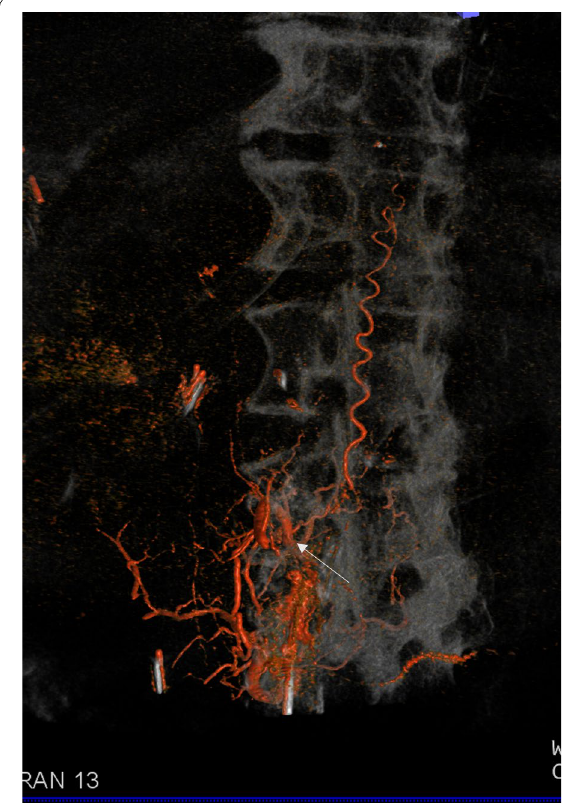
Fig. 3 3D reconstructed image of from the DSA study demonstrating the Spinal dural AVF at the right L1/L2 neural foramen level